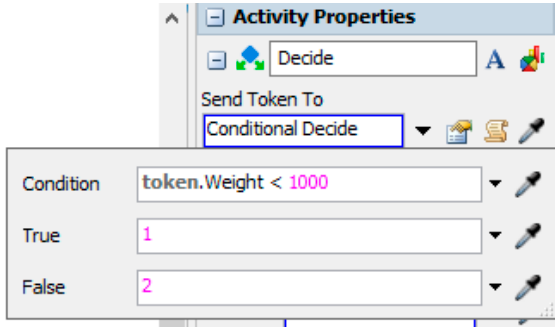
Figure 8. Example of a deterministic decision with FlexSim (conditional version).